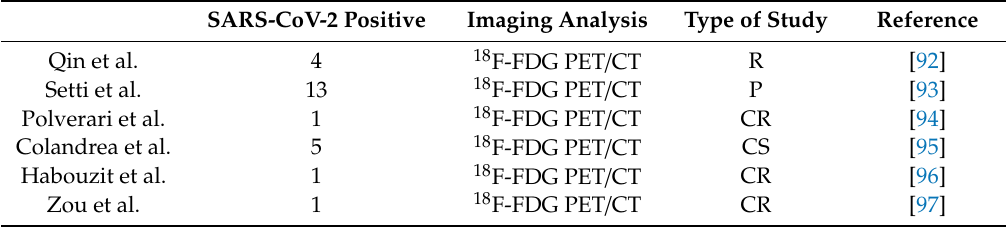
Table 5. Table reported the main nuclear medicine studies about SARS-CoV-2 pandemic. SARS-CoV-2 Positive Imaging Analysis Type of Study Reference Qin et al. 4 18 F-FDG PET / CT R [92] Setti et al. 13 18 F-FDG PET / CT P [93] Polverari et al. 1 18 F-FDG PET / CT CR [94] Colandrea et